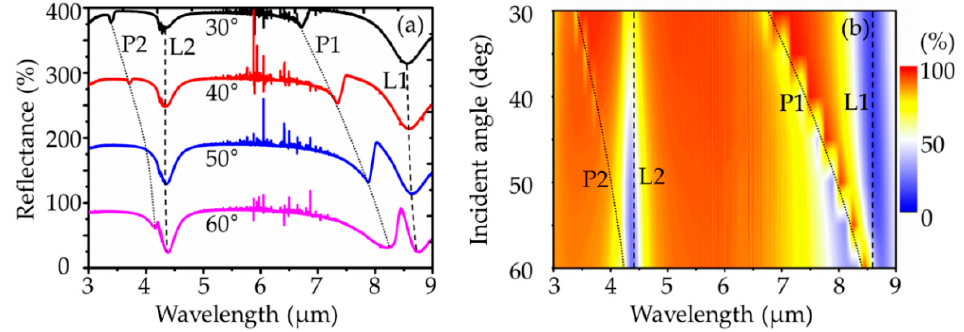
Figure 2. ( a ) Reflection spectra and ( b ) reflectance contour plot of the metagrating sample at different incident angles.